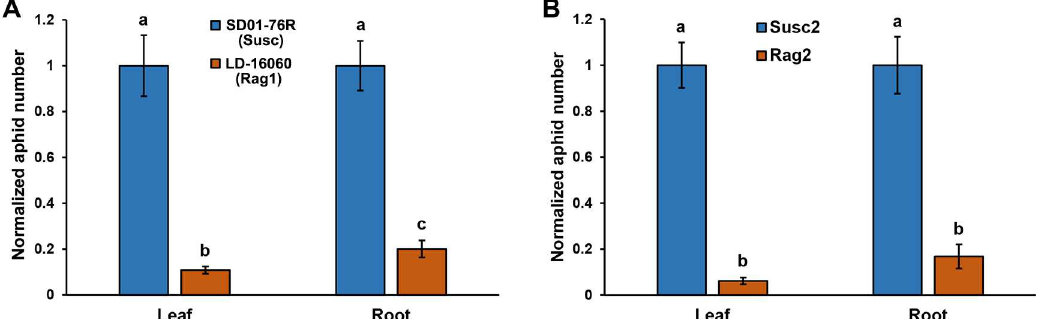
Fig 3. Soybean hairy roots can be used to screen for resistance. A . Aphid performance on roots and full plants of a susceptible cultivar (SD01-76R) and a related resistant cultivar (LD-16060)carrying the Rag1 resistancegene. Full plants and hairy roots were infested with 10 aphids,and the number of aphidsafter 7 days was recorded. B . Aphid performance on roots and full plants of a susceptiblecultivar (Susc2) and a related resistant cultivar (Rag2) carrying the Rag2 resistance gene. Full plants and hairy roots were infested with 10 aphids,and the number of aphids after 7 days was recorded. Two independentexperiments with 10 replicatesfor each cultivar and treatment were carried out. In A and B , numberof aphids for each replicatewas normalized to the averagenumber of aphidson the susceptiblecultivar for each organ, to facilitate comparison. Statistically significantdifferencesare indicatedby different letters abovethe bars (Student’s t -test; p < 0.05).Error bars = standard